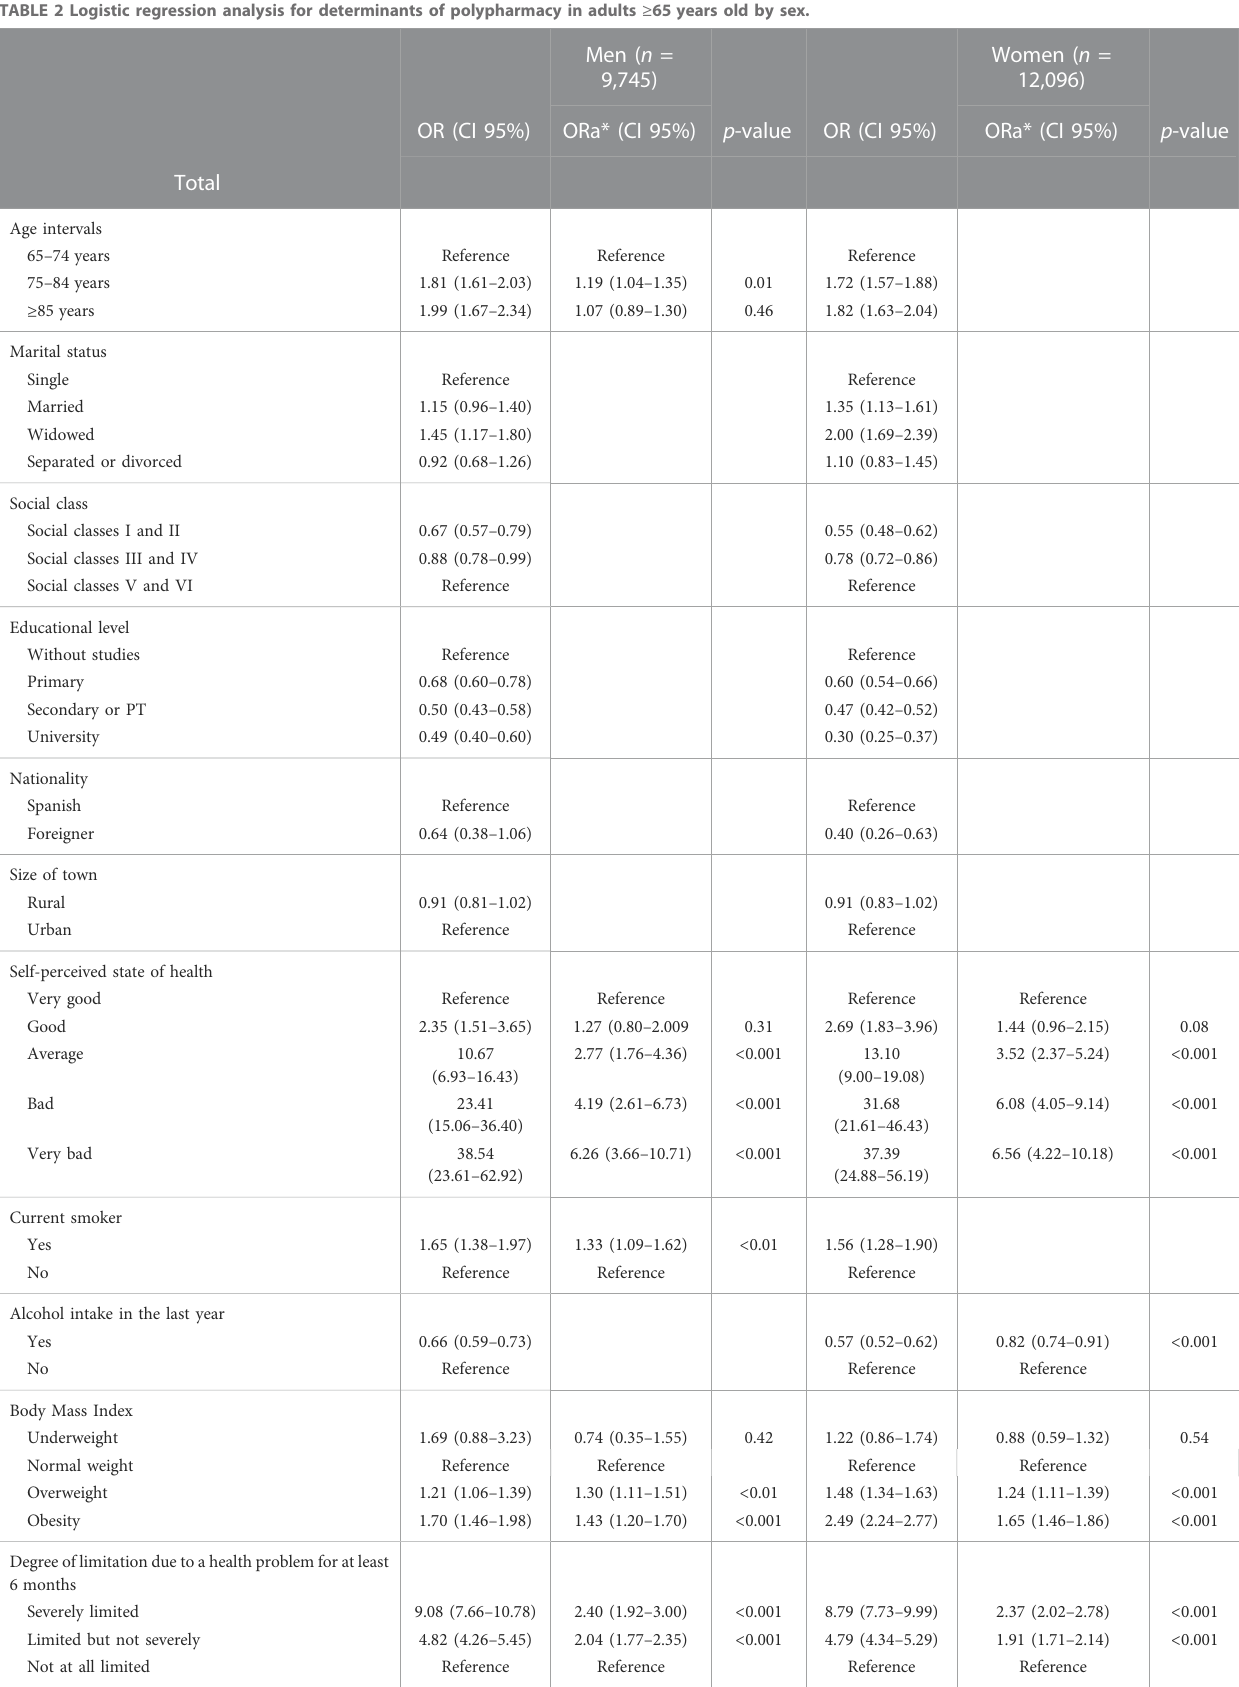
TABLE 2 Logistic regression analysis for determinants of polypharmacy in adults ≥ 65 years old by